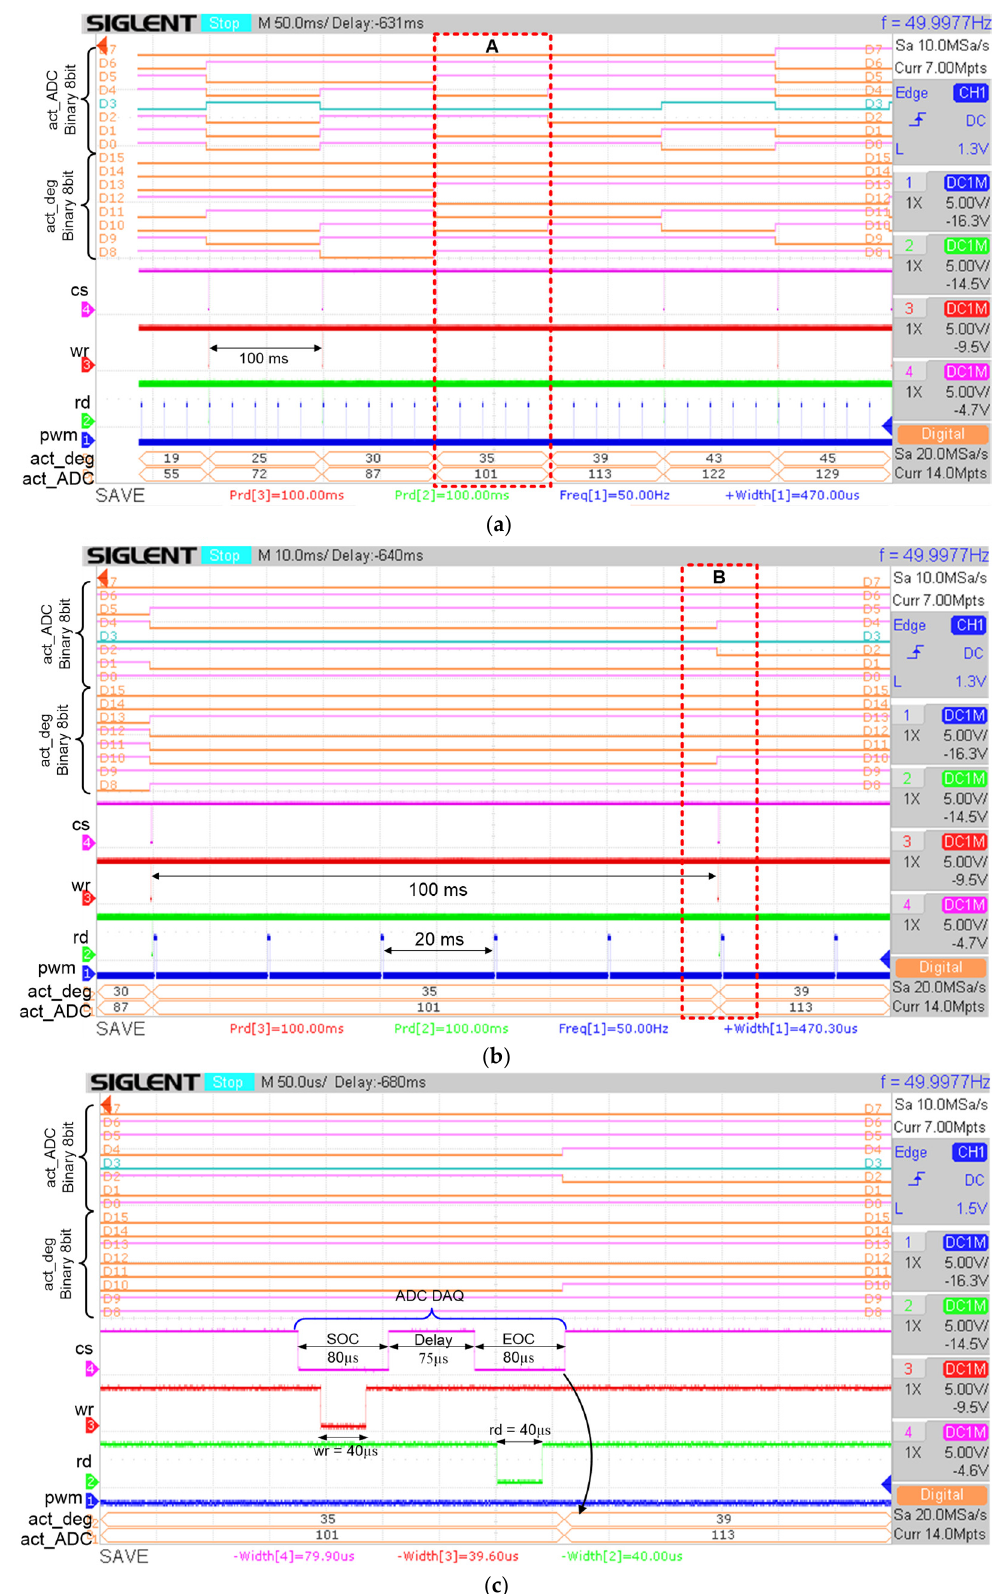
Figure 16. ADC data acquisition operation from the ADC (ADC0804) chip: ( a ) Overview of acquired ADC data every 100 ms; ( b ) Zoom view into marked area A; ( c ) Zoom view into marked area B.